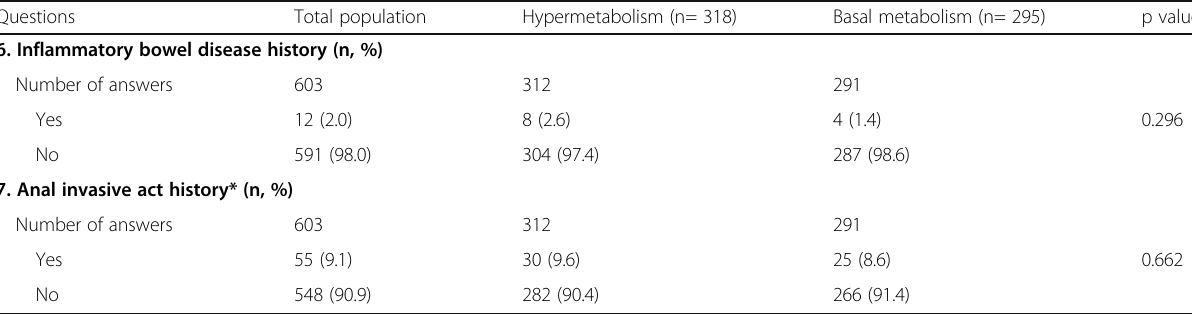
Table 2 Questionnaires data (Continued)